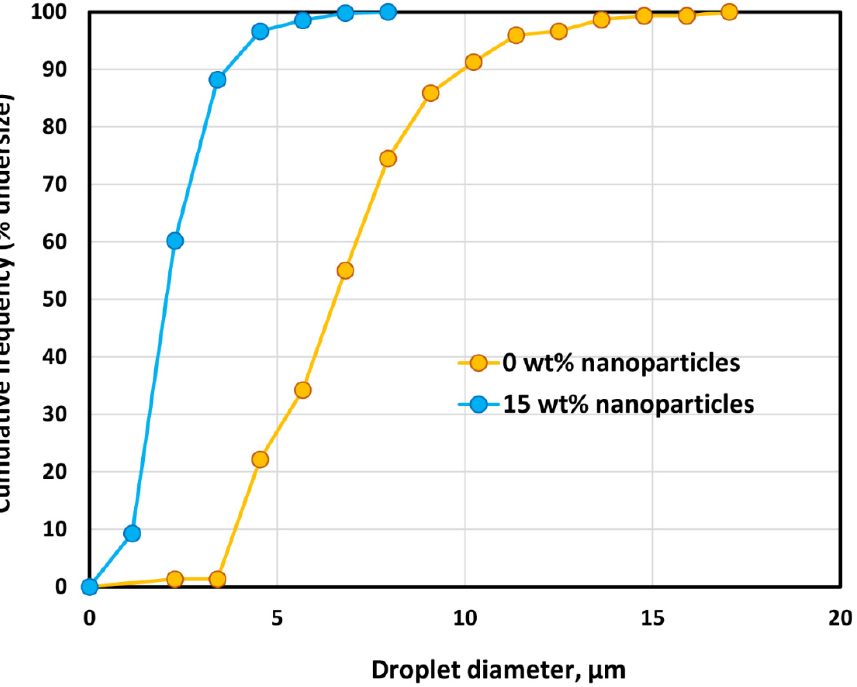
Figure 16. Droplet size distributions of O/W emulsions without and with nanoparticles. The oil concentration of emulsions is approximately 65 wt%.